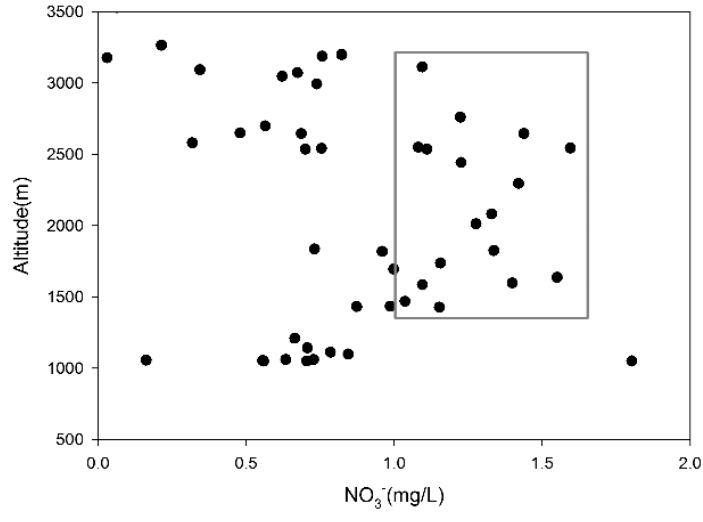
Figure 8. Altitude versus NO 3 − concentrations of the surface water.